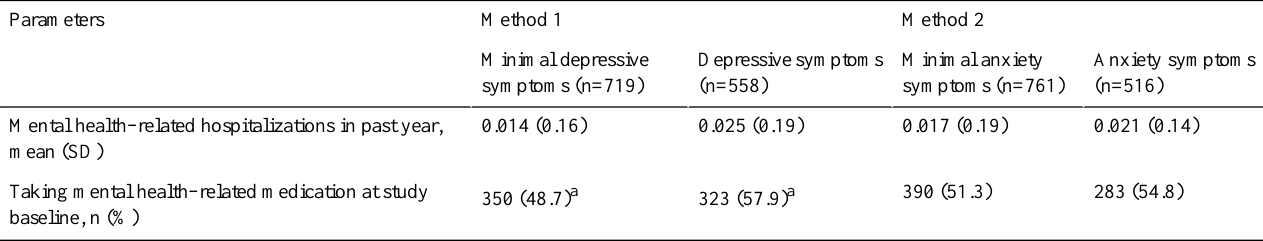
Table 4. Health care utilization, medication usage, and disease